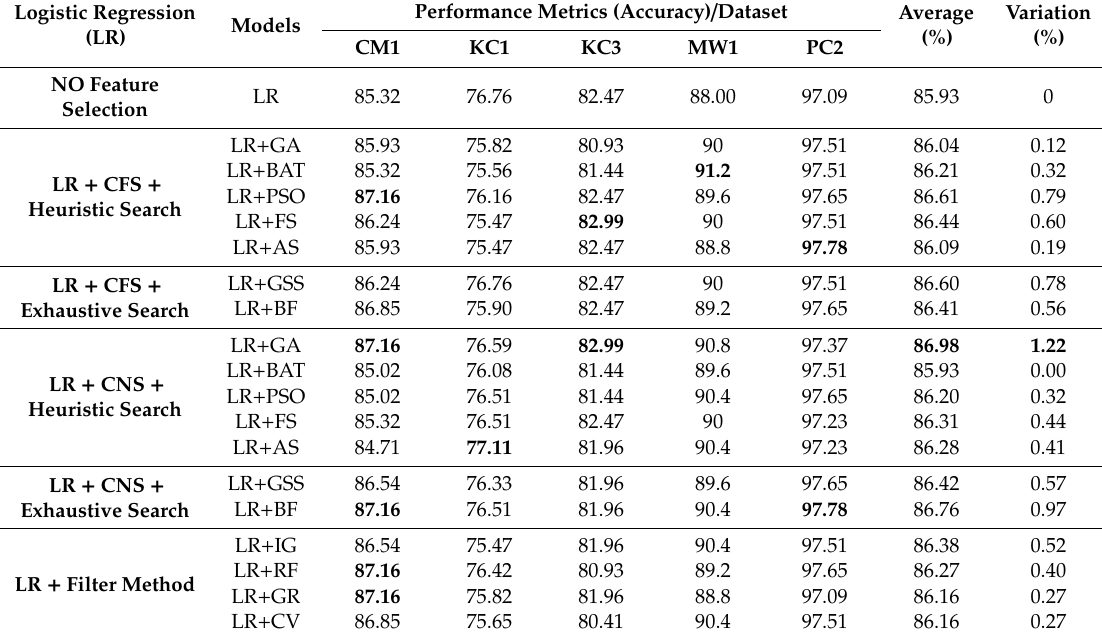
Table 8. Accuracy Values of Logistic Regression Classifier on Full and Reduced